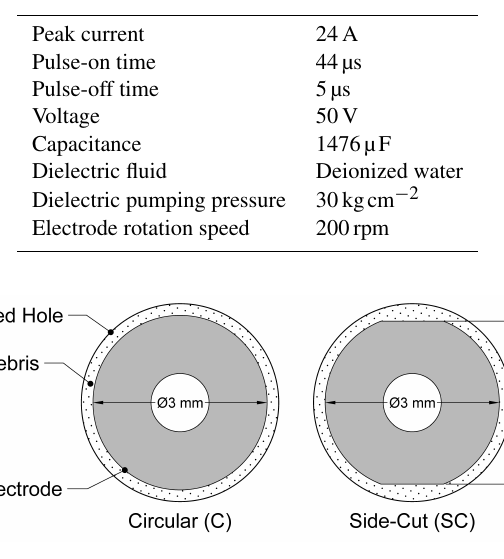
Figure 1. Circular and side-cut electrode